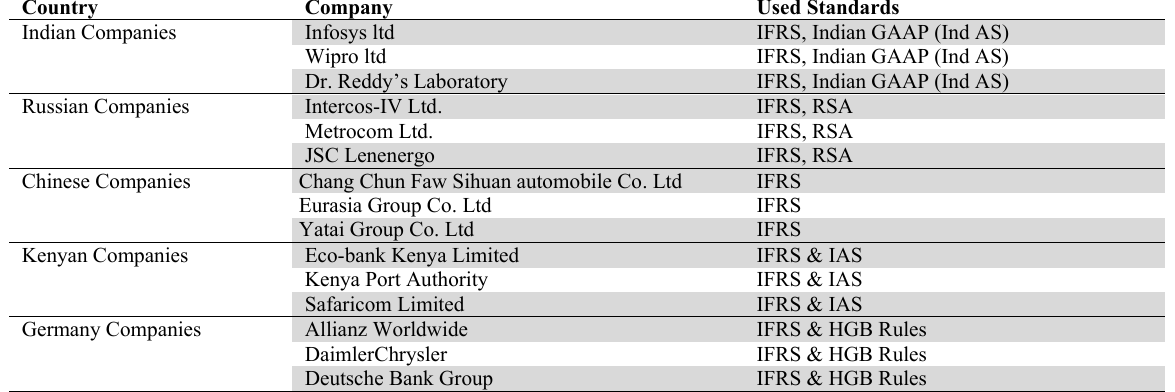
Accounting standards used by selected